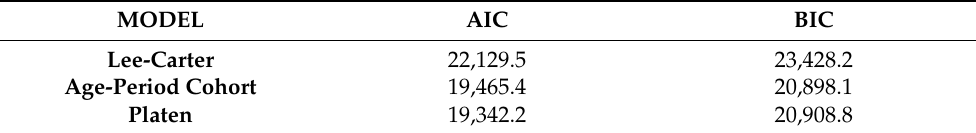
Table A1. Comparison of LC, APC and PLAT Stochastic Mortality Models: AIC and BIC values.